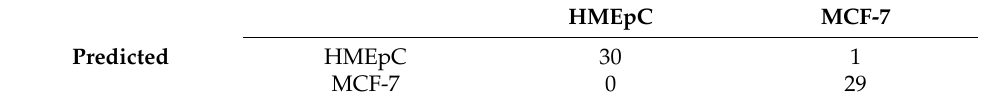
Figure 3. LDA Discrimination Plot. Linear discrimination factors of normal HMEpC and breast cancer MCF-7 cells are plotted by blue boxes and red circles, respectively. Table 1. Confusion matrix of linear discriminant analysis (LDA) Actual.